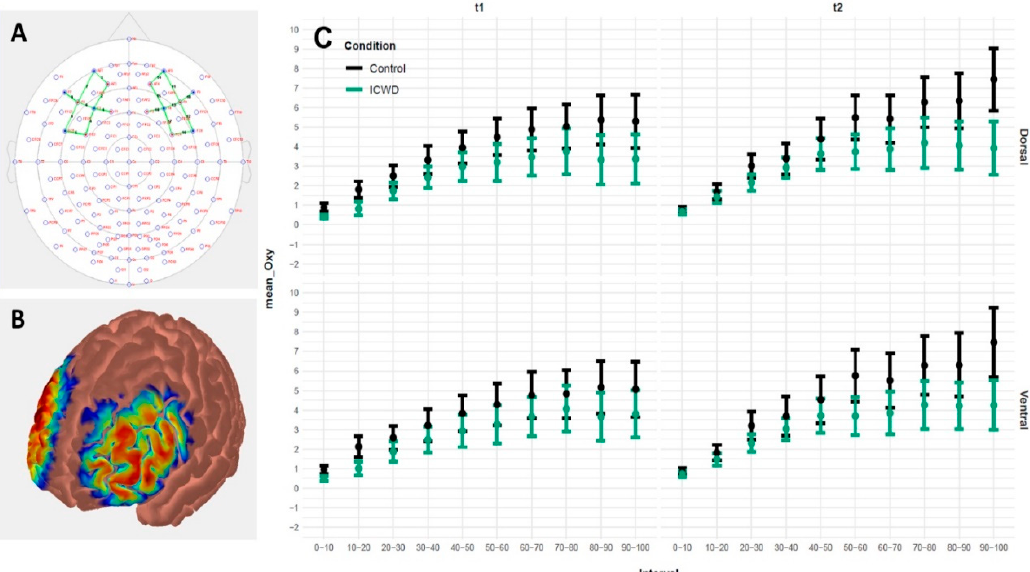
Figure 3. fNIRS measurements. ( A ). The sensitivity profile was created with Atlas Viewer (Aasted, et al., 2015) and it indicates that the chosen optode placements capture the lateral prefrontal cortex (lPFC) reasonably well. It represents Monte Carlo random walks of 1e7 photons (per optode) migrating through a standard atlas (Colin27, B ). Panel C displays the change in oxygenation throughout the fatiguing task [0%–10%] vs. [10%–20%] vs. [90%–100%]) and is displayed separately for experimental conditions, experimental session and regions of interest (ROI; ventral and dorsal lPFC). Error bars represent SEM. ICWD corresponds to income compensated wage decrease.